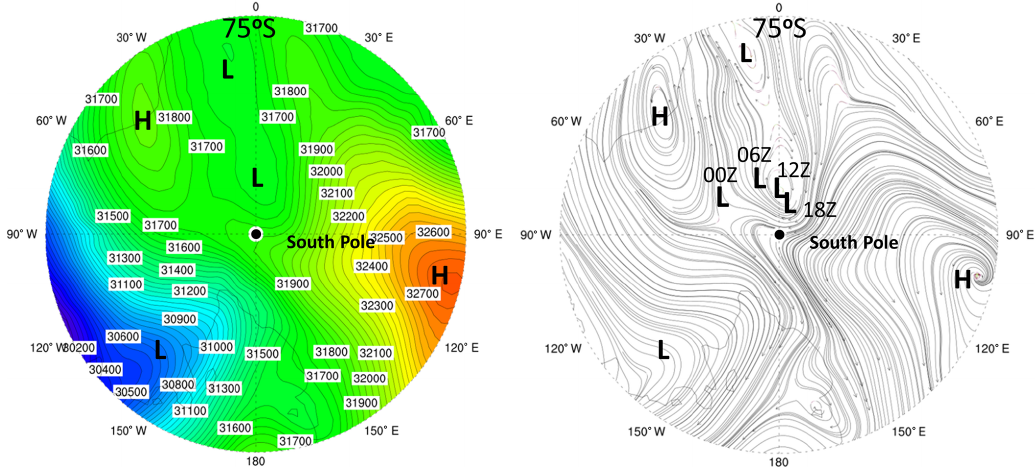
Figure 9. Geopotential at 650hPa at 12Z on JD337 (3 December 2006) and wind field (using curly vector representation) from ERA-I (Dee et al., 2011). A trough of low geopotential lies along 0 ◦ with higher geopotential and anticyclonic winds over the high plateau. Lows and highs are indicated, in addition to the location of a small cyclonic circulation, at 6h intervals on JD337 that brought easterly winds to the SP. By 12Z on JD338, the low to the north-northeast had intensified and produced consistent northeasterly winds at